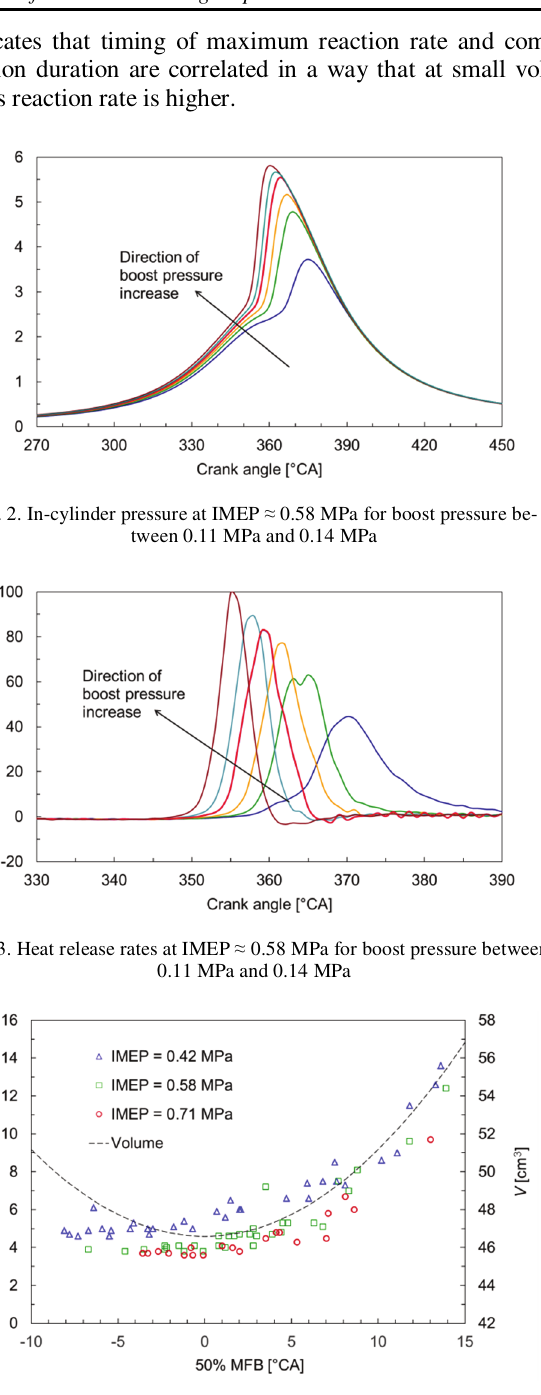
Fig. 4. Combustion duration expressed as period between 5% and 95% MFB as a function of location of 50% MFB for all investigated conditions. Dotted line shows in-cylinder volume